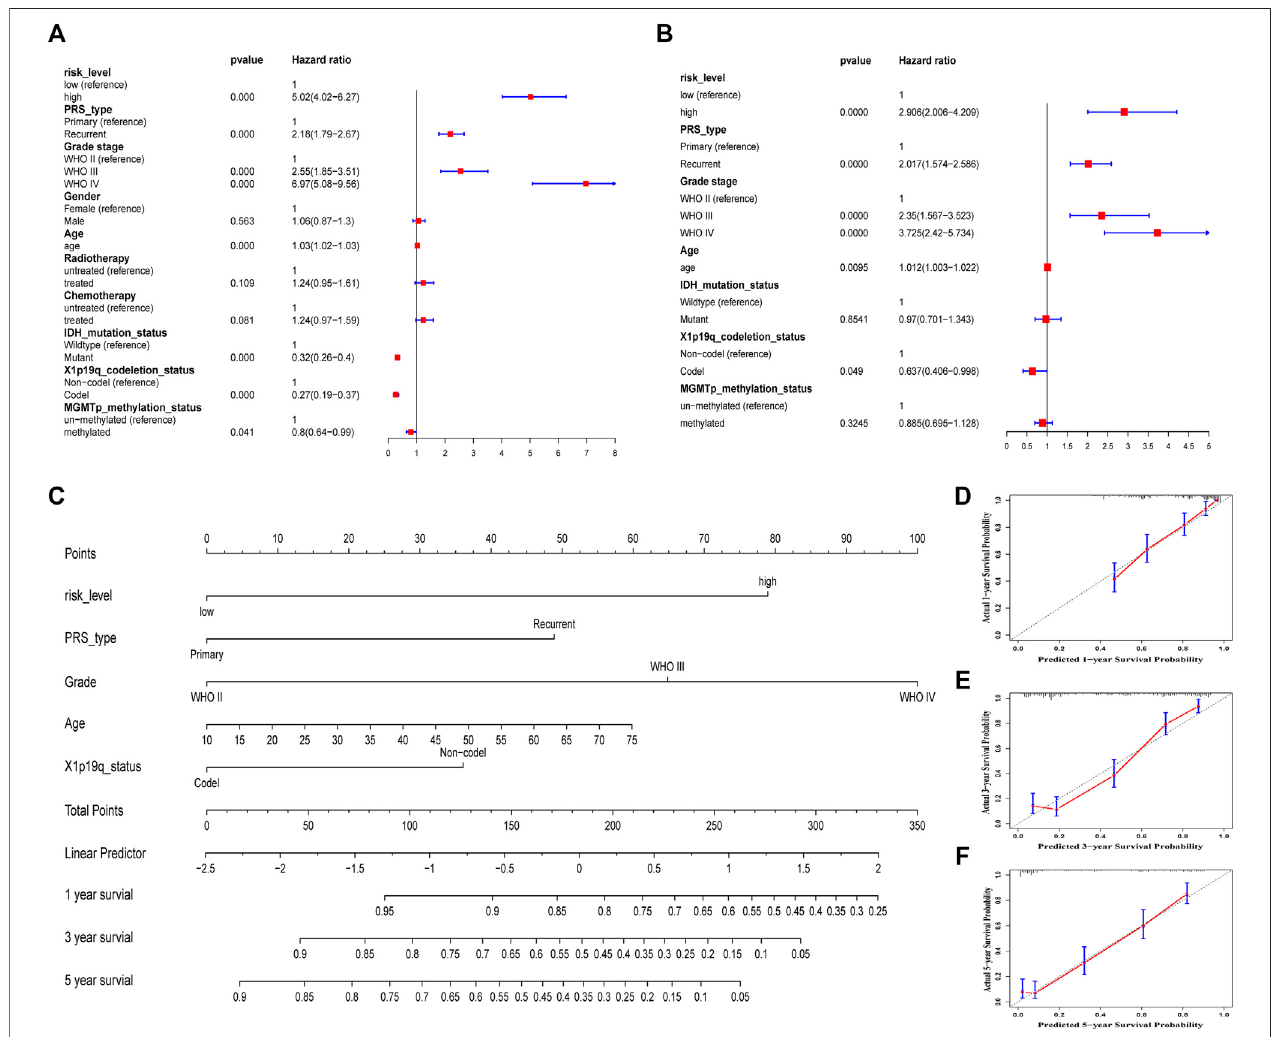
FIGURE 8 | Construction and assessment of a nomogram in the training CGGA693 cohort. (A) Univariate Cox regression. (B) Multivariate cox regression. (C) A prognostic nomogram was used to predict the 1-, 3-, and 5-years survival probability of patients with glioma. (D – F) Calibration curves of the nomogram at 1, 3, and 5 years. The Y -axis and X -axis represent the actual and nomogram-predicted survival probability, respectively.